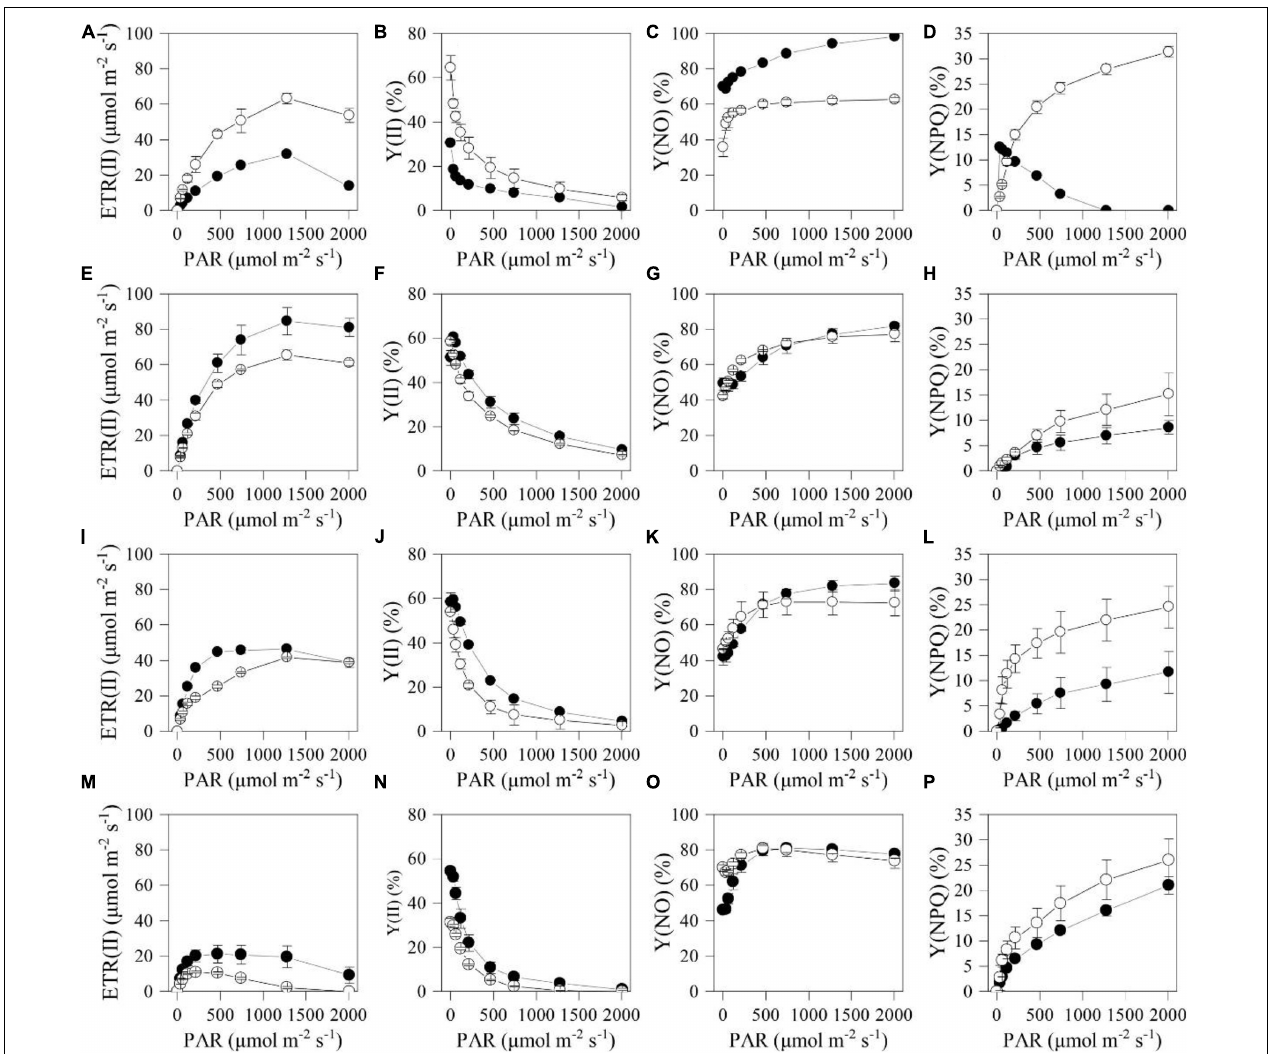
FIGURE 4 | Light response curves of the chlorophyll fluorometry parameters for the heterotrophically (filled cycle)- and photoautotrophically (empty cycle)-grown S. acuminatus cells subjected to the high-light and N-limited conditions. Chlorophyll fluorescence were obtained with a series of photosynthetically active radiances (0, 34, 65, 122, 218, 467, 746, 1279, 2004 µ mol photons m − 2 s − 1 ) to calculate ETR(II), Y(II), Y(NO) and Y(NPQ). (A–D) , (E–H) , (I–L) , and (M–P) were measured in 0, 12, 24, and 144 h of cultivation, respectively. The values represent mean ± S.D. ( n =